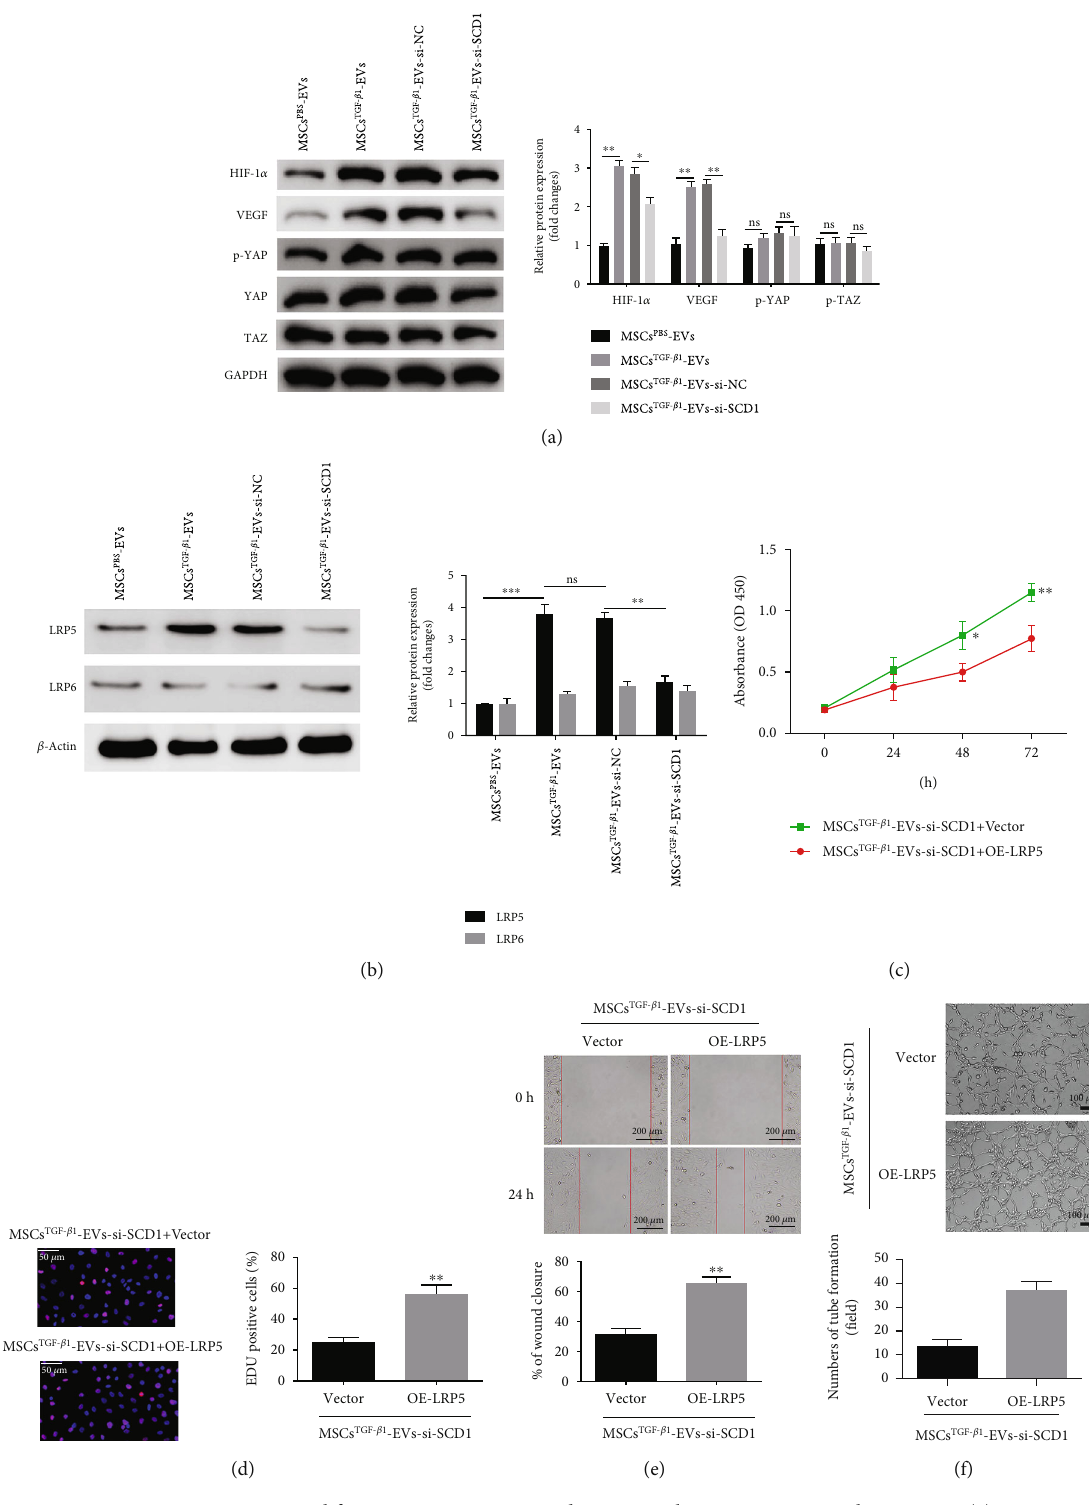
Figure 8: EV-SCD1 promotes HUVEC proliferation, angiogenesis, and migration by interactions involving LRP5. (a) Expression levels of HIF-1 α , VEGF, TAZ, YAP, and p-YAP in HUVECs after transfection with MSC PBS -EVs, MSC TGF- β 1 -EVs, MSC TGF- β 1 -EV-si-NC, or MSC TGF- β 1 -EV-si-SCD1, n = 3 . (b) Expression level of LRP5 and LRP6 in HUVECs after transfection with MSC PBS -EVs, MSC TGF- β 1 - EVs, MSC TGF- β 1 -EV-si-NC, or MSC TGF- β 1 -EV-si-SCD1, n = 3 . (c – f) CCK-8 (c), EdU (d), scratch wound assays (e), and tube formation (f) were used to verify the functional role of LRP5 on cell proliferation, migration, and angiogenesis in HUVECs, n = 3 . Data are expressed as mean ± SD ; ∗ P < 0 : 05 , ∗∗ P < 0 : 01 , and ∗∗∗ P < 0 : 001 . ns: no signi fi cance; MSCs: mesenchymal stem cells; EVs: extracellular vesicles; HUVECs: human umbilical vein endothelial